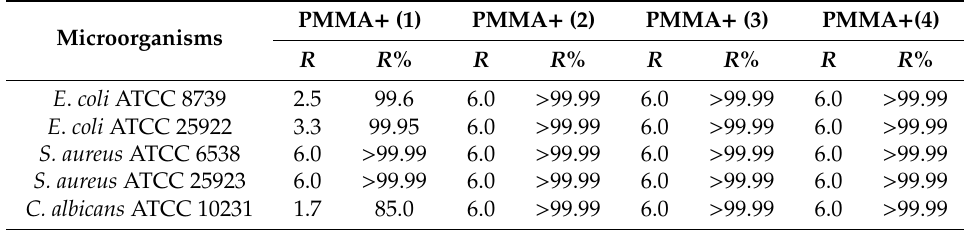
Table 6. Antimicrobial activity of the (PMMA + TOCs) systems ( R = biocidal rate (%), R % = reduction percentage). PMMA + (1) PMMA + (2) PMMA + Microorganisms